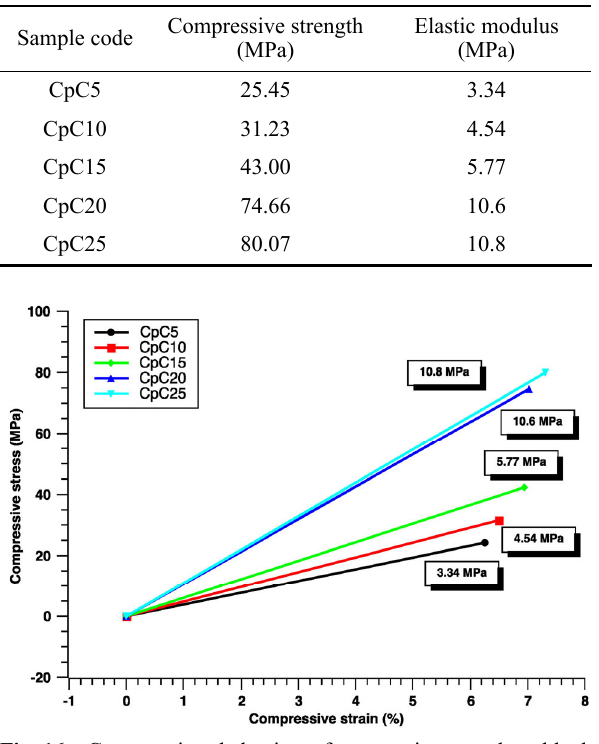
Fig. 16 Compression behavior of composite samples; block values represent the elastic modulus.